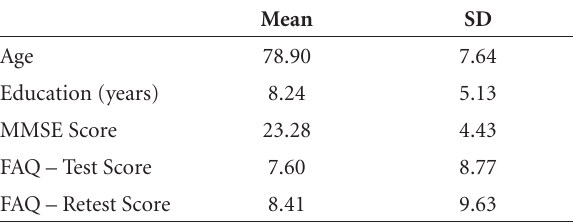
Table 2. Descriptive statistics of the demographic characteristics and test scores of 68